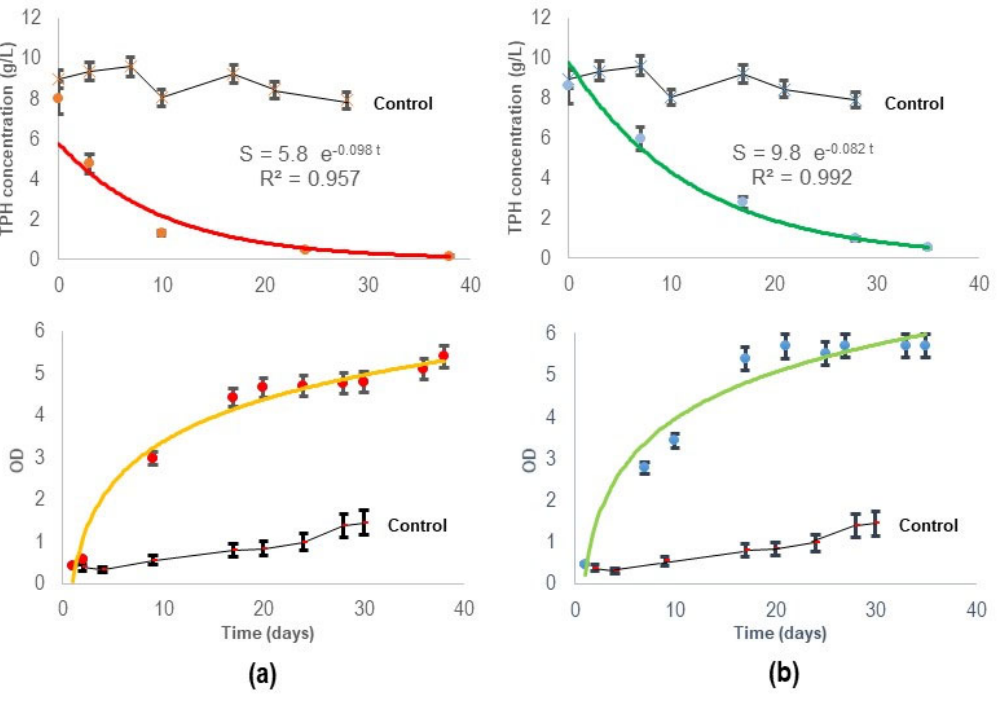
Figure 8. Kinetic curves of Arab Light degradation (measured as TPH) and optical density by Bacillus licheniformis ( a ) and Pseudomonas putida ( b ). Error bars represent standard deviation (triplicates). Control shows a weak growth of no oleophilic microorganisms (no TPH decay).